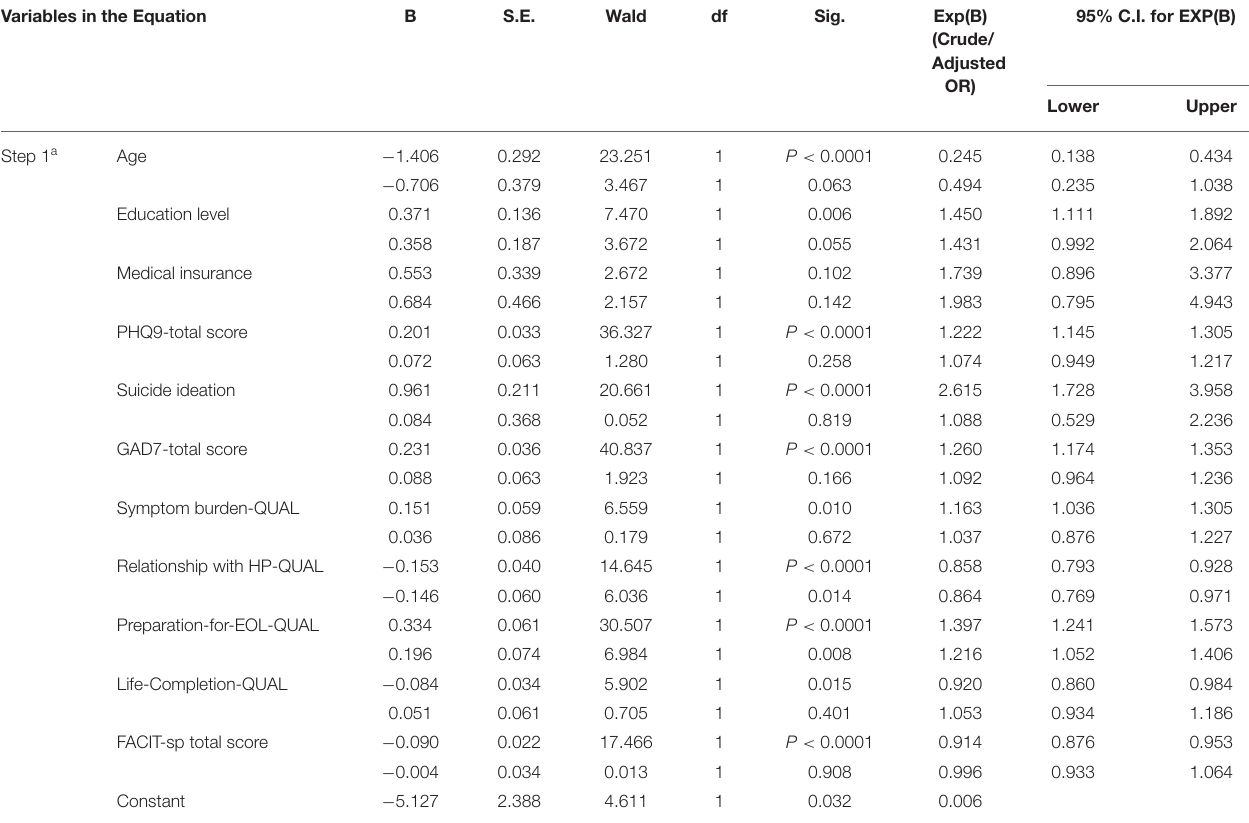
TABLE 4 | Results of risk factors for death anxiety from Univariate and Multivariate Logistics Regression Analysis. Variables in the Equation B